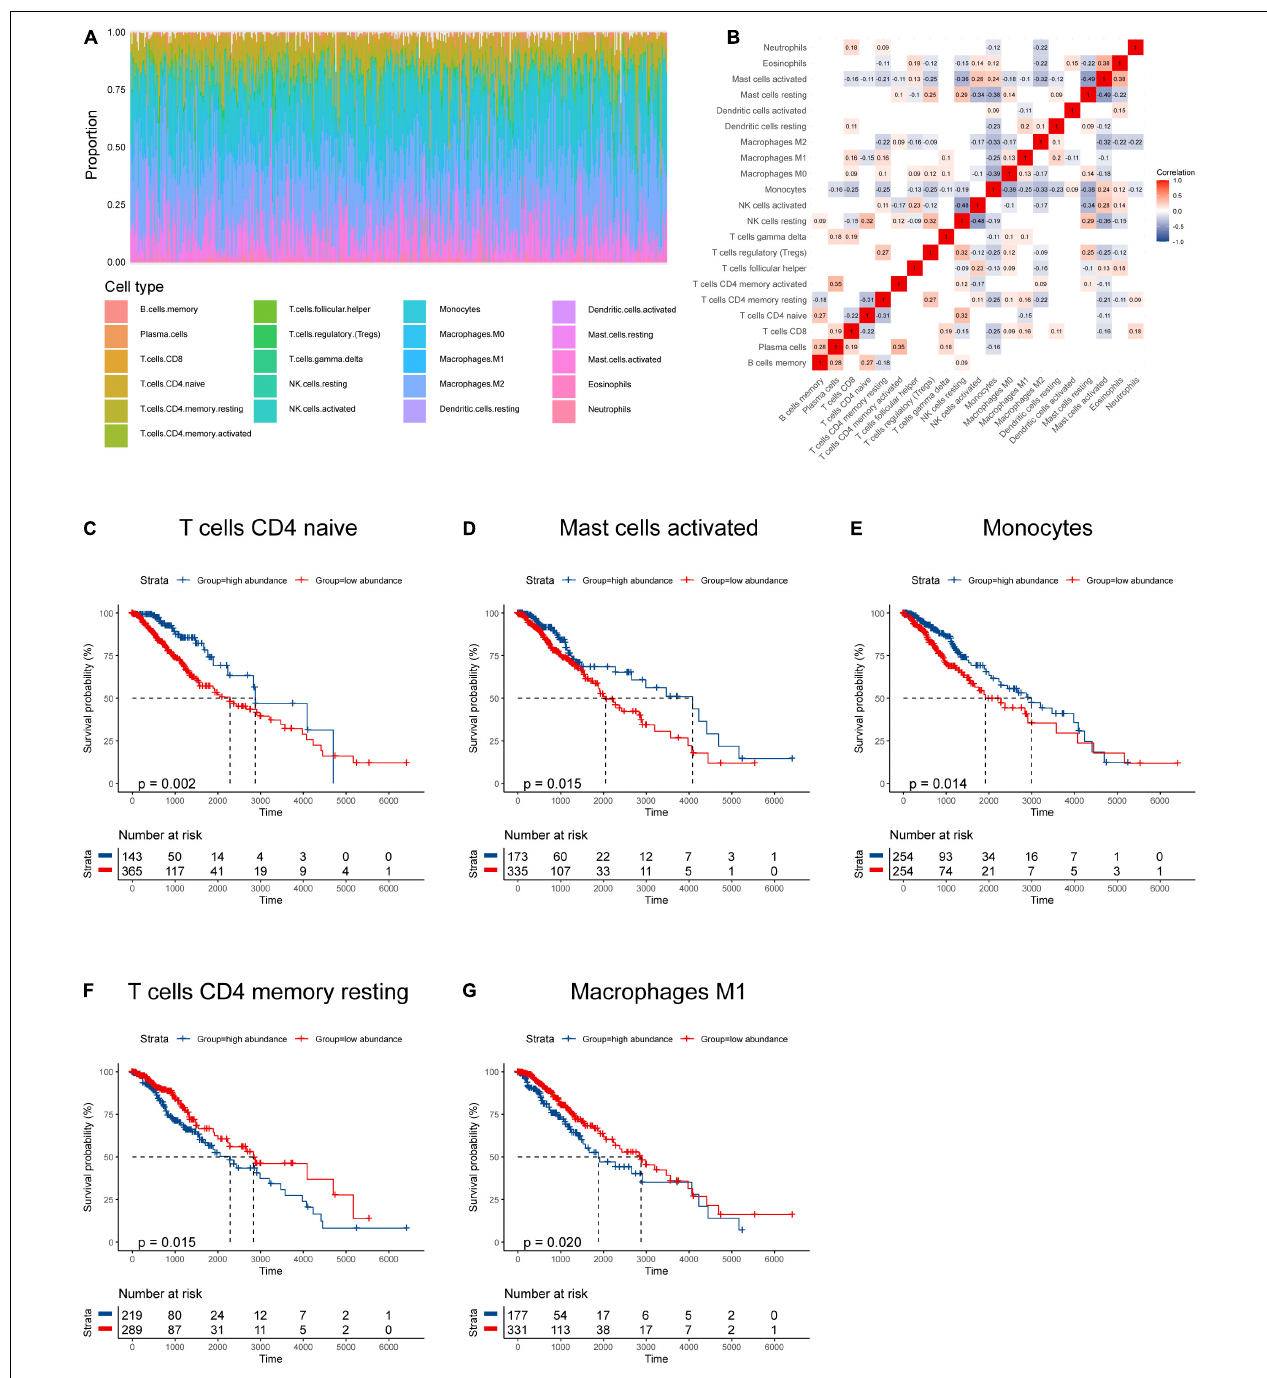
FIGURE 1 | Immune infiltration profile and its relationship to survival in gliomas. (A) Proportions of various immune infiltrates. (B) The correlations among various immune infiltrates (non-significant values were omitted). (C–G) Kaplan–Meier survival curves based on immune infiltrates that were significantly related to patient